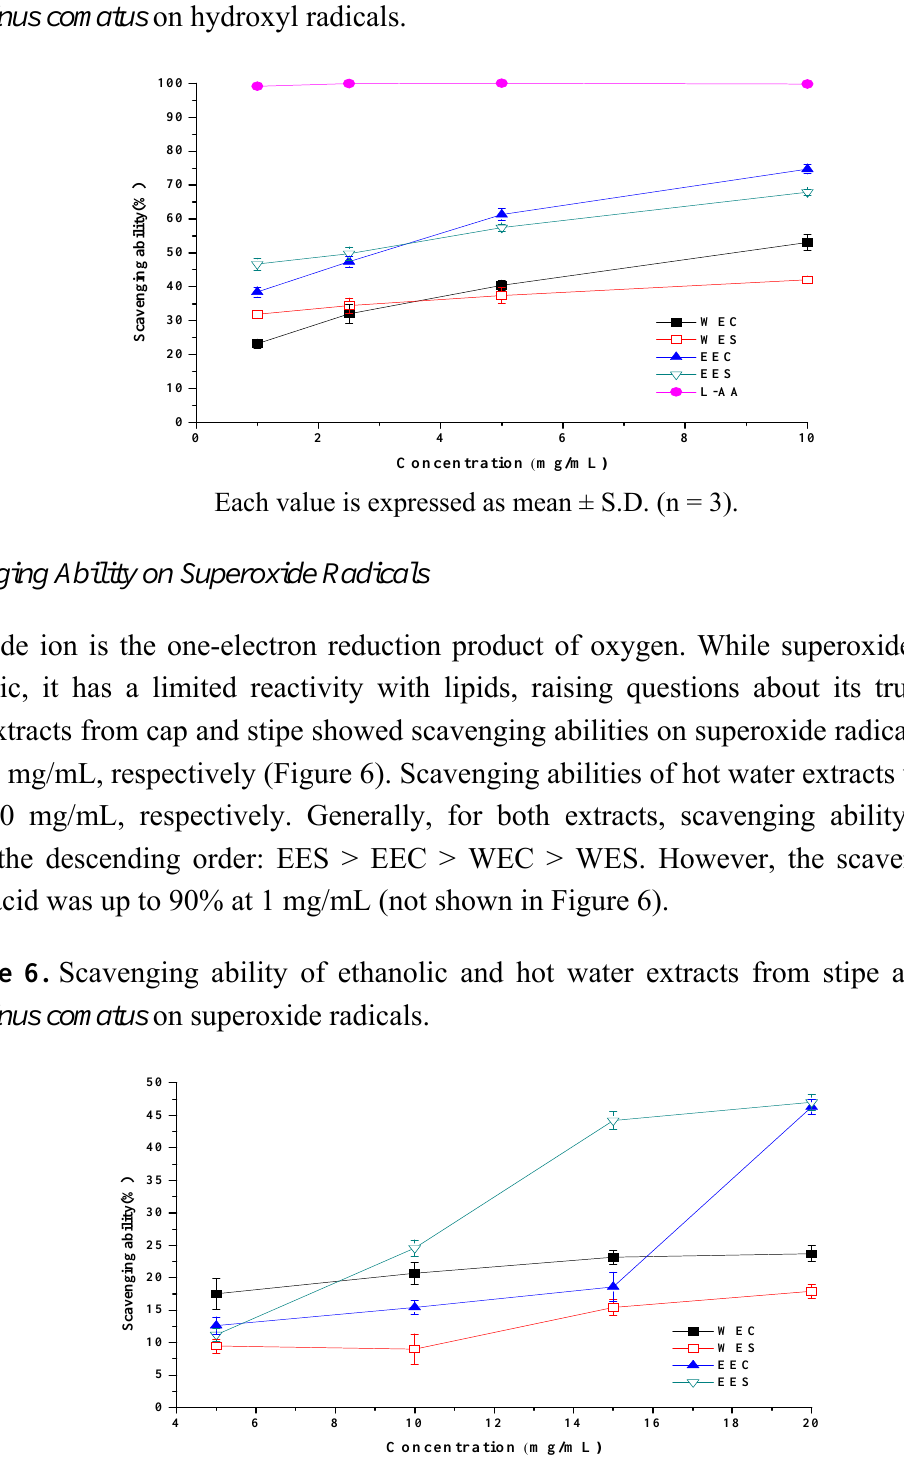
Figure 5. Scavenging ability of ethanolic and hot water extracts from stipe and cap of Coprinus comatus on hydroxyl radicals.